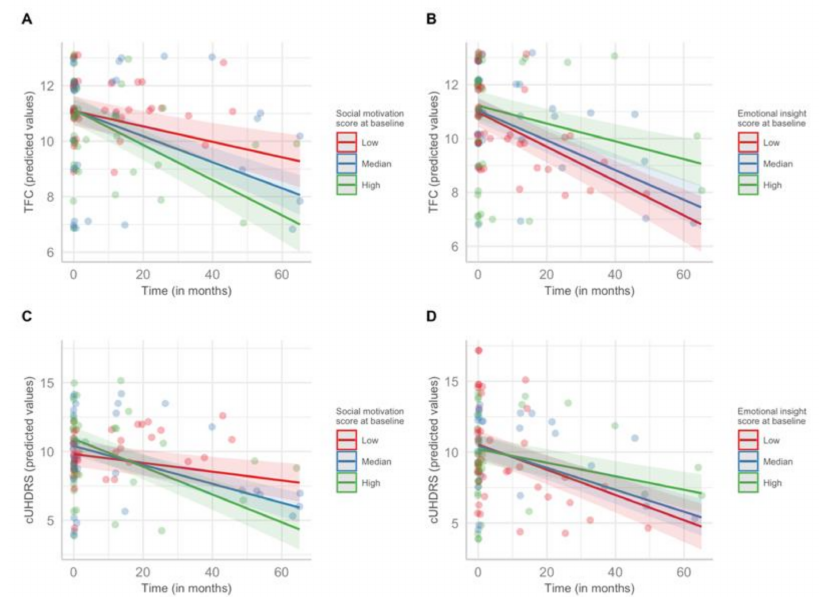
Figure 3. SRSQ scores at baseline and disease progression in HD patients only: ( A ) social motivation and predicted values of TFC (Total Functional Capacity) over time; ( B ) emotional insight and pre- dicted values of TFC over time; ( C ) social motivation and predicted values of cUHDRS (Composite Unified Huntington’s Disease Rating Scale) over time; ( D ) emotional insight and predicted values of cUHDRS over time. Predicted values of TFC and cUHDRS are calculated using the estimated marginal means to adjust on the basis of age, sex, number of CAG repeats, and education level. Low, median, and high SRQS scores correspond to the first quartile, the median, and the third quartile, respectively. Colored bands represent 95% confidence